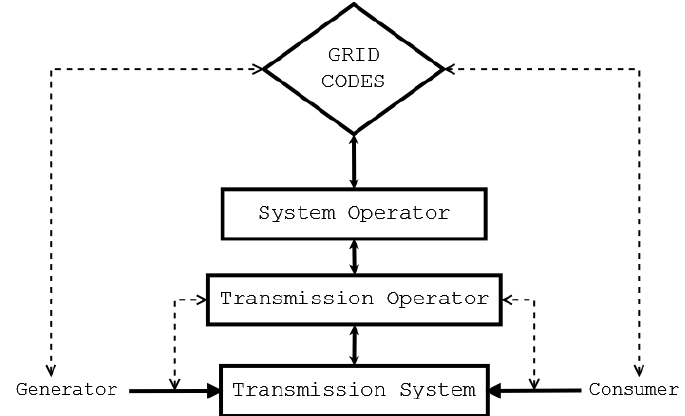
Figure 31. Voltage transformers between the WEC and the grid.